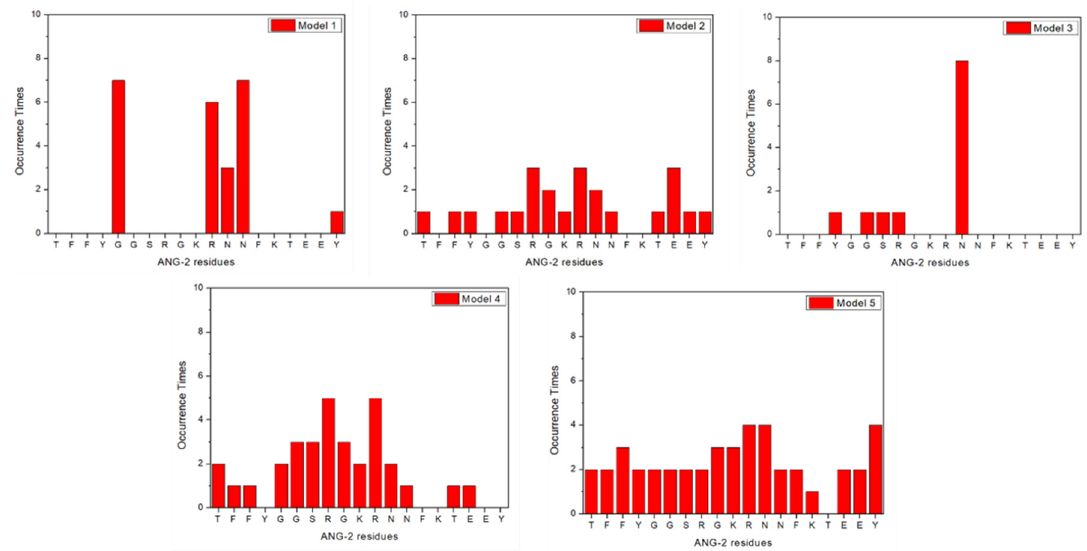
Figure 3. Angiopep-2 residues involved in LRP-1 binding from model 1 to model 5.